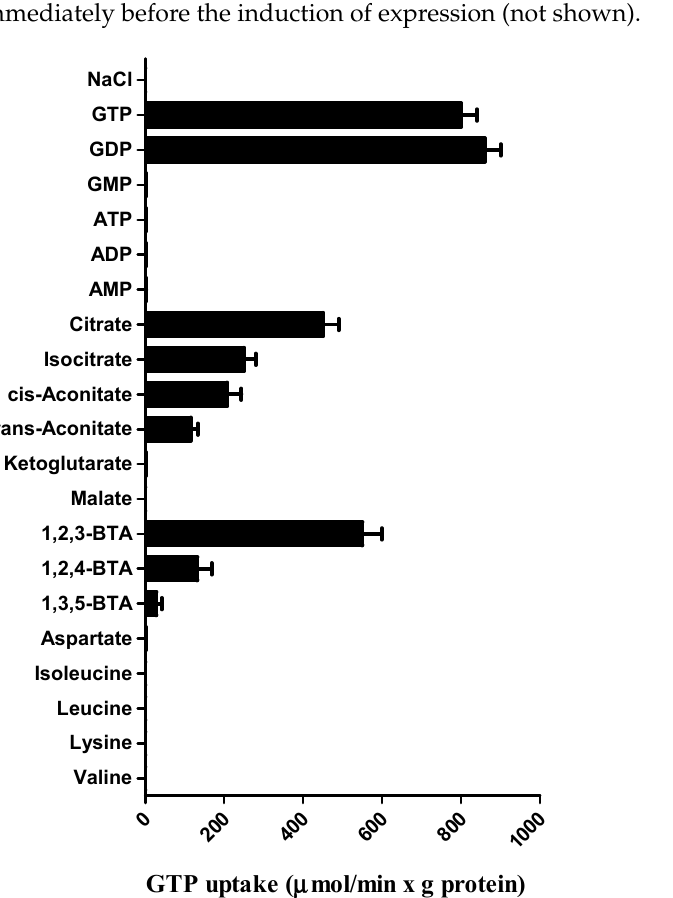
Figure 2. Dependence of Ggc1p transport activity on internal substrate. Proteoliposomes were preloaded internally with the reported substrates (5 mM). Transport was started by adding 1 µ M [8- 3 H] GTP to proteoliposomes reconstituted with Ggc1p and stopped after 20 s.